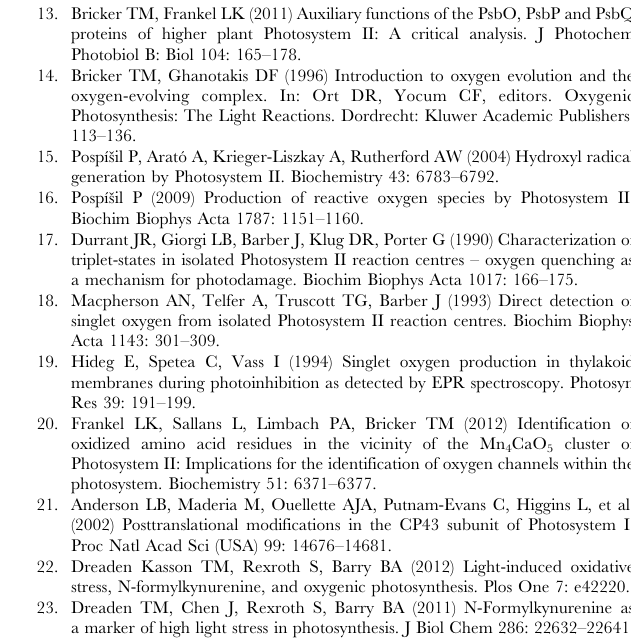
Figure S1 Mass Spectrometry Data from the Unmodi- fied Peptide. 235 AFNPTQAEETYSMVTAN 252 R and the Oxidatively Modified Peptide 235 AFN 238 P + 16 239 T + 16 QA 242 E- 30 ETYSM + 16 VTAN 252 R of the D2 Protein A. Top, spectrum of the CID dissociation of the unmodified peptide 235 AFNPTQAEE- TYSMVTAN 252 R. Various identified ions are labeled. Bottom, table of all predicted masses for the y- and b- ions generated from this peptide sequence. Ions identified in the CID spectrum (above) are shown in red. The b’ ++ , b’ + y’ ++ and y’ + ions are generated by the neutral loss of water while the b* ++ , b* + y* ++ and y* + ions are generated from the loss of ammonia. B. Top, spectrum of the CID dissociation of the modified 235 AFN 238 P + 16 239 T + 16 QA 242 E-30 ETYSM + 16 VTAN 252 R. Various identified ions are labeled. Bottom, table of all predicted masses for the y- and b- ions generated from this peptide sequence. Ions identified in the CID spectrum are shown in red. The b’ ++ , b’ + y’ ++ and y’ + ions are generated by the neutral loss of water while the b* ++ , b* + y* ++ and y* + ions are generated from the loss of ammonia. The p values for the unmodified and modified peptide were 10 2 13 and 10 2 14 , respectively.